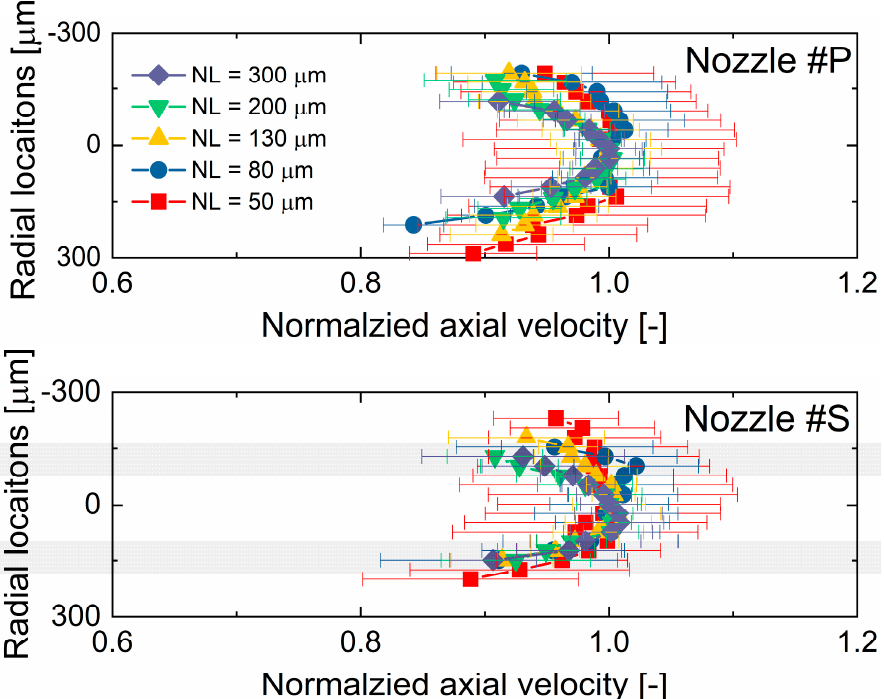
Figure 9. Normalized nozzle − exit spray velocity distributions at different needle lifts.